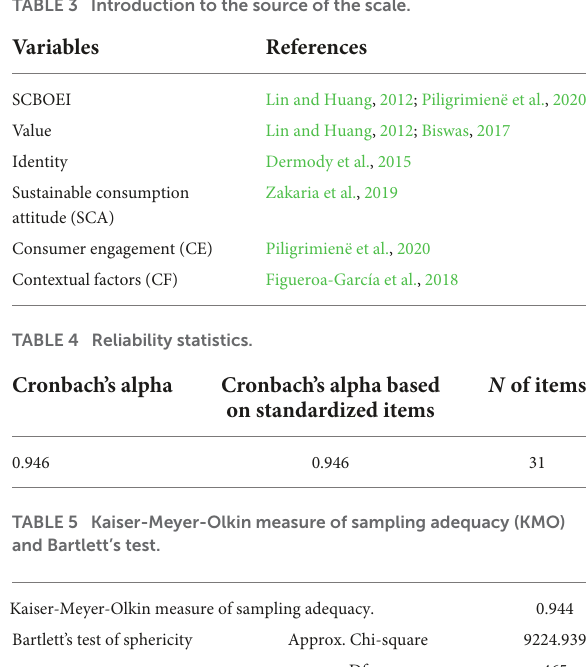
TABLE 3 Introduction to the source of the scale.